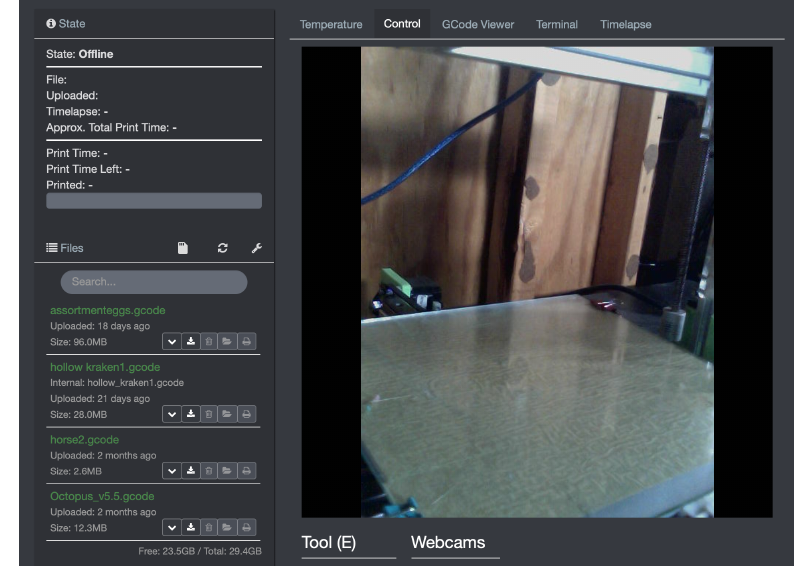
Figure A8. Example of exposed 3D printer found with